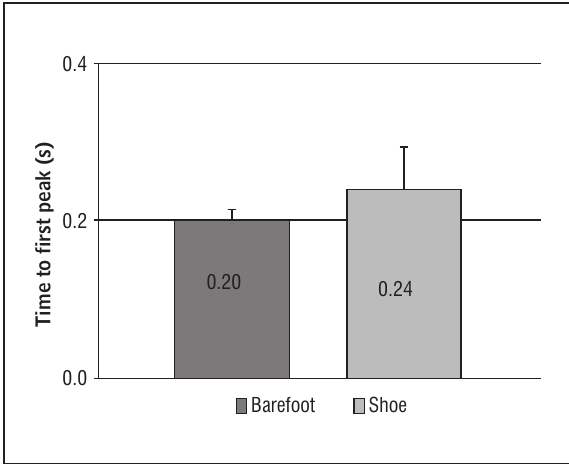
Figure 3 - Time of first peak force for barefoot and footwear situation